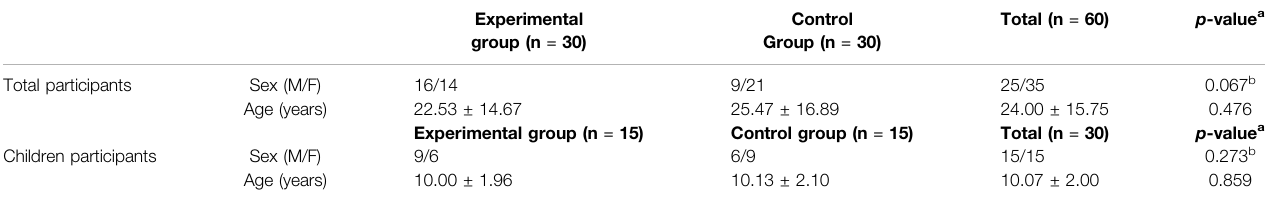
TABLE 2 | Demographic information.